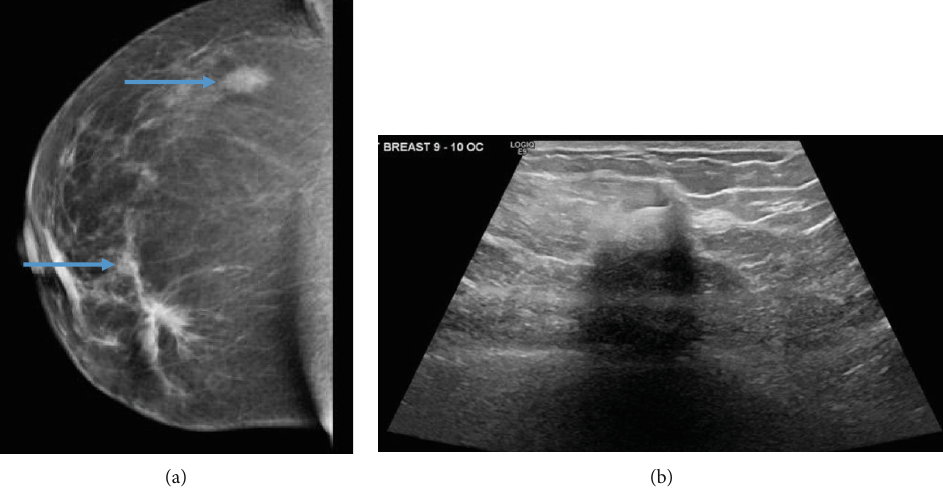
Figure 7: (a) Two lesions in the right breast on mammogram (blue arrows). (b) Right breast lesion.